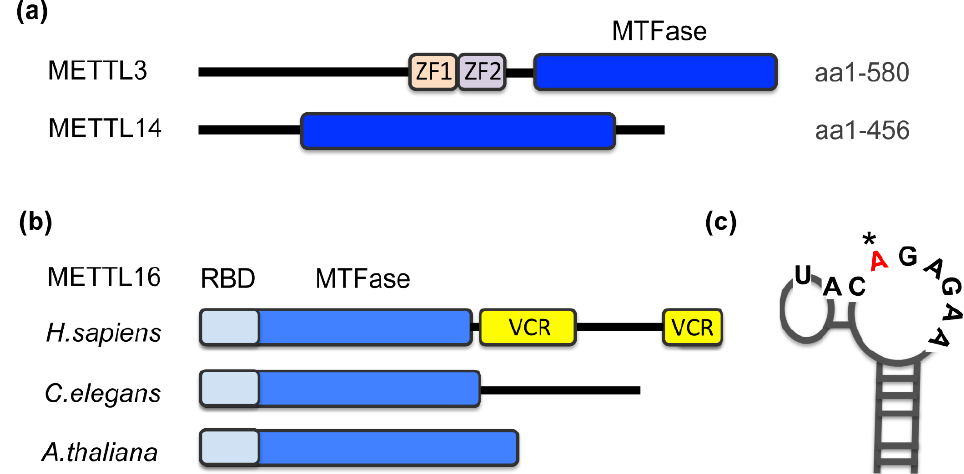
Figure 1. Domain organization of m 6 A methyltransferases ( a ) METTL3, METTL14 and ( b ) METTL16. Schematic indicates domain architecture and function. MTFase, methyltransferase Rossmann fold; ZF, zinc finger domain; RBD, RNA-binding domain, VCR, vertebrate-conserved region. ( b ) METTL16 from selected species that are discussed in this review: human (aa 1-562), worm (METT-10) and Arabidopsis (FIONA1). ( c ) Stem-loop structure of a typical METTL16 target site with a specific nonamer sequence; the modified adenosine is highlighted (*). Based on the first hairpin of MAT2A 3′ UTR.